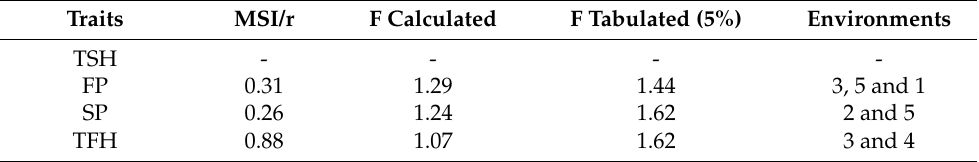
Table 3. Stratification of sugarcane microregions in the state of Pernambuco, Brazil, based on the similarity pattern of response of genotypes, for each environment. Traits MSI/r F Calculated F Tabulated (5%)